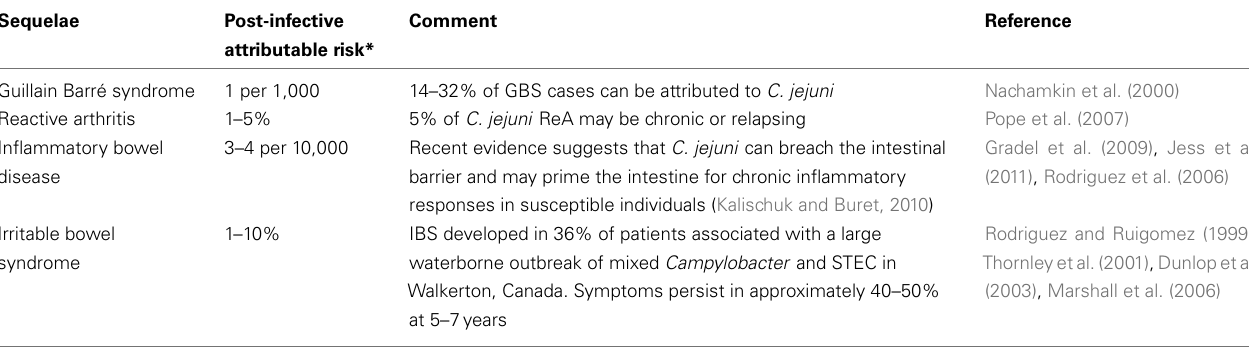
Table 2 | Summary evidence of post- Campylobacter infection risk of select chronic health